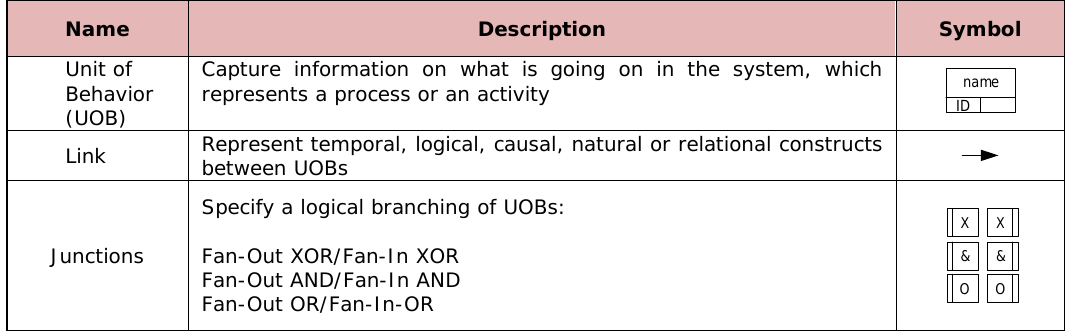
Figure 3. “IDEF3 process